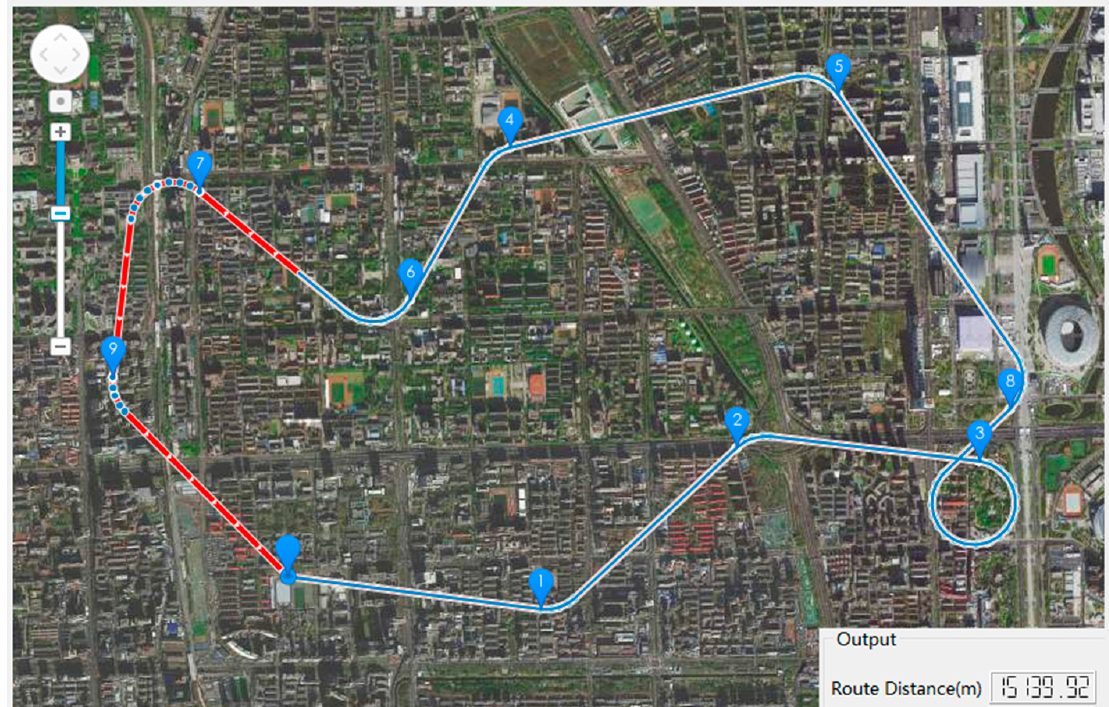
Figure 12. Schematic diagram of the output result of the route planning software. The blue line with arrows is the calculated best route, and the red line is the route that the simulated airship has traveled. And the output shows that the total route distance of the optimal route is 15,139.92 m.